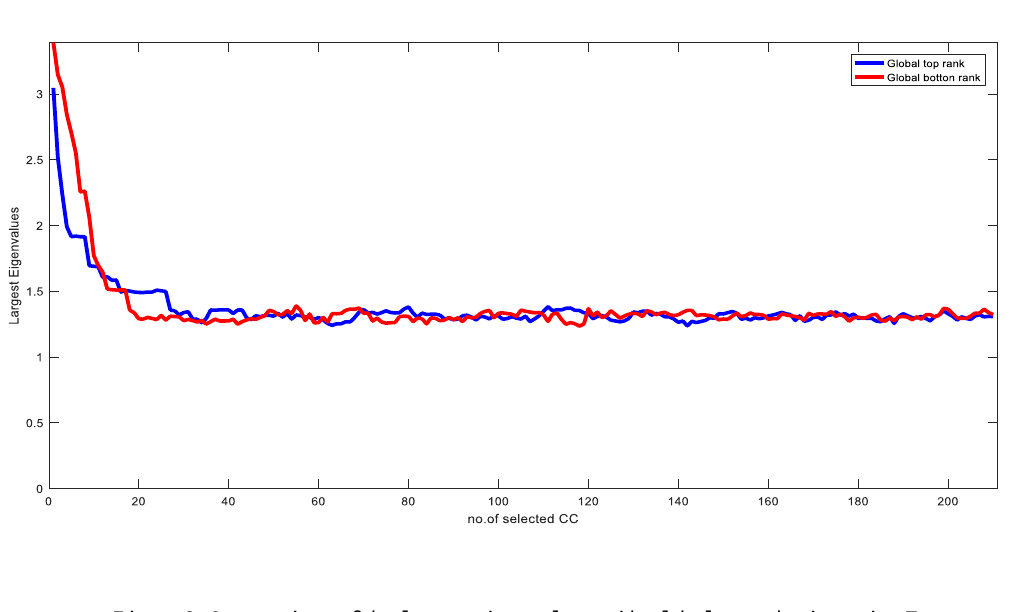
Figure 8. Comparison of the largest eigenvalues with global perturbation using Top- Ranked and Bottom Ranked